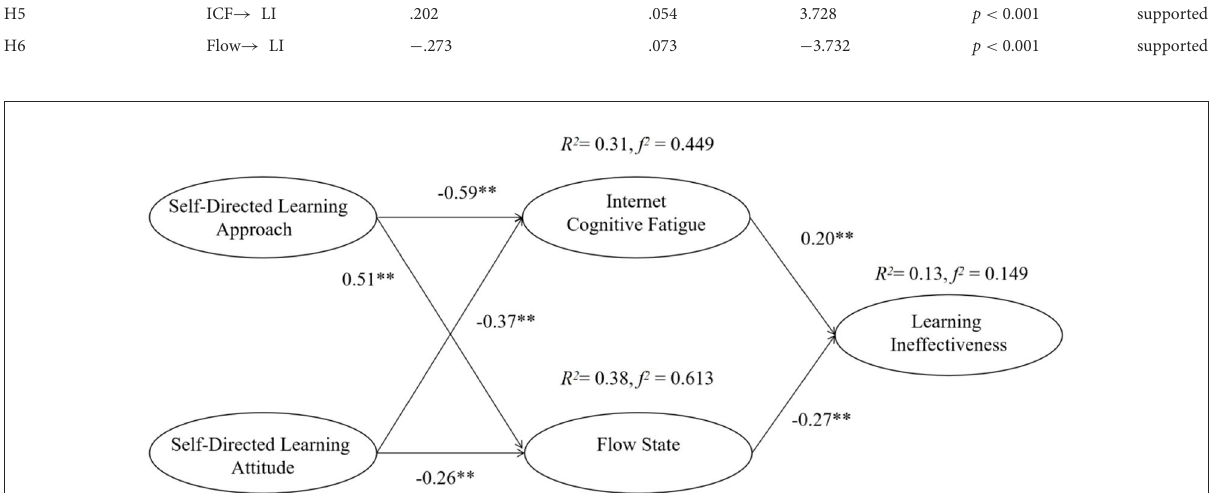
FIGURE2 The verification of the research model. ** p < 0.01.